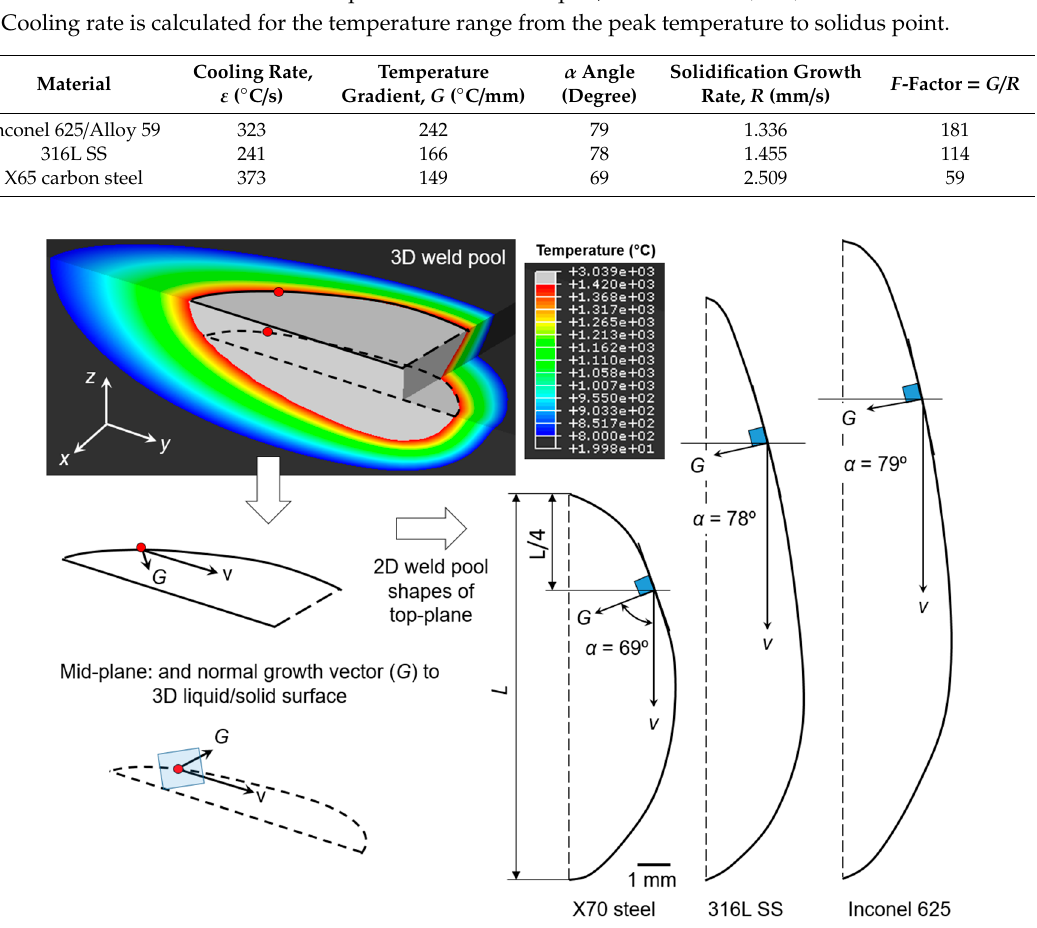
Table 3. Estimated solidification parameters at the WM centerline on top-plane. Cooling rate is calculated for temperature range from peak temperature to solidus point.